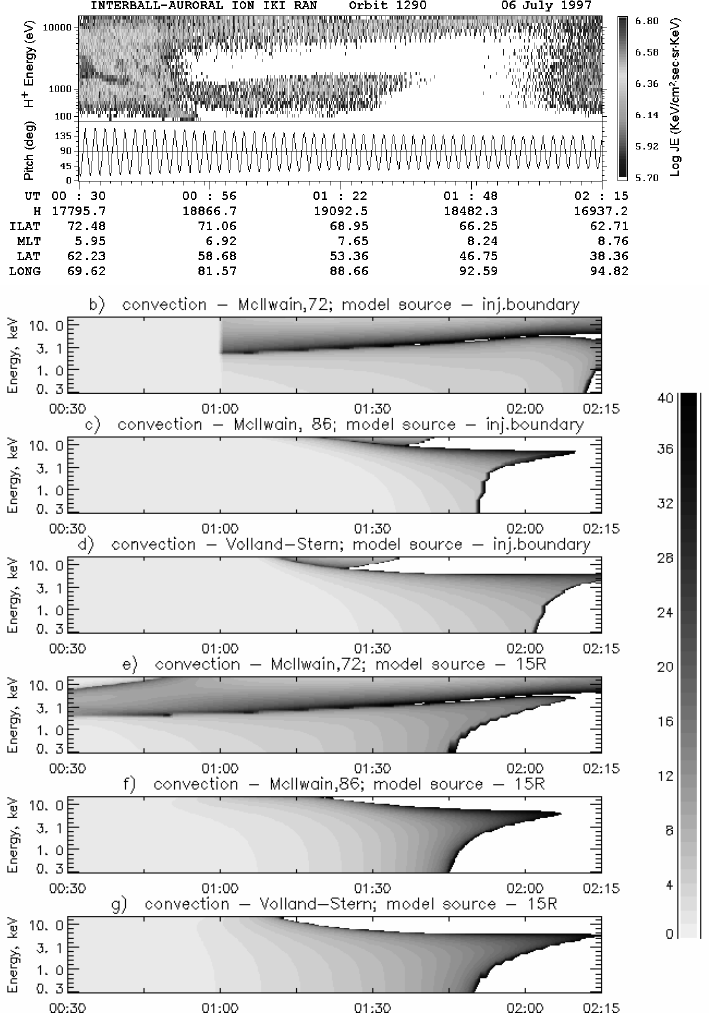
Fig. 9. Same as Fig. 7 for 6 July 1997 (orbit